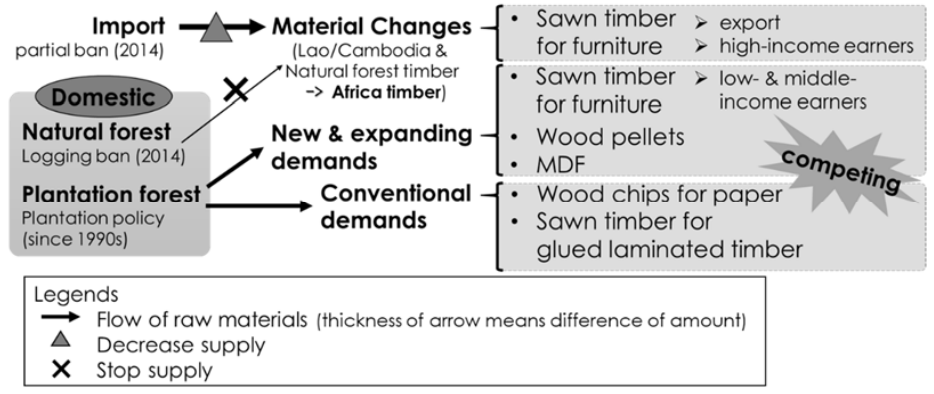
Figure 1. Changes in raw material origin and types of demand for plantation forest timber. Source: